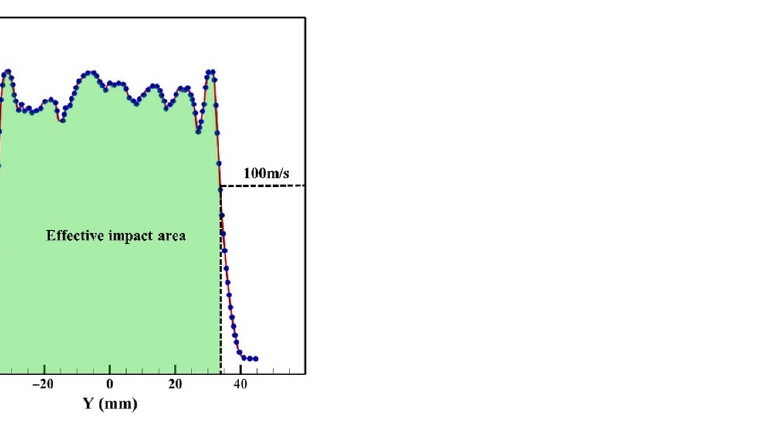
Figure 8. The velocity distribution curve of the high-pressure water jet on the hot rolling surface along line A in Figure 7c.